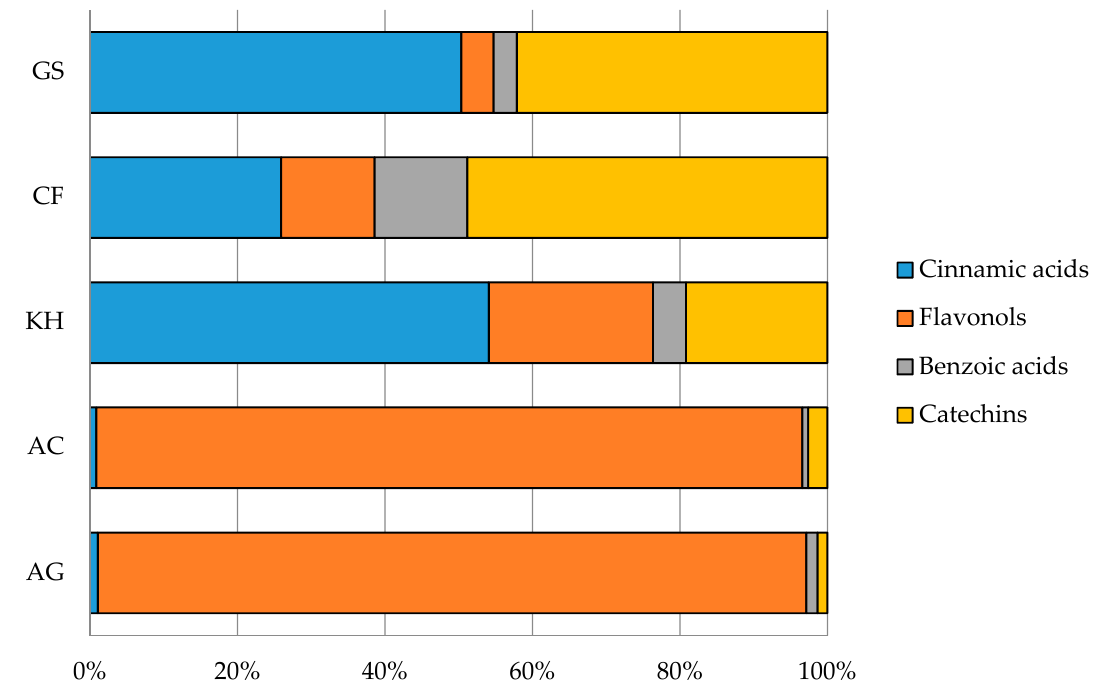
Figure 2. Phenolic composition of analysed dried fruit snacks. Mean values are shown ( n = 3). AG = Malus domestica Borkh., ‘Golden Delicious’; AC = Malus domestica Borkh., ‘Camela’; KH = Actinidia deliciosa (A.Chev.) C.F.Liang and A.R.Ferguson, ‘Hayword’; CF = Diospyros kaki L.F., ‘Fuyu’; GS = Lycium barbarum L., ‘Sweet’.